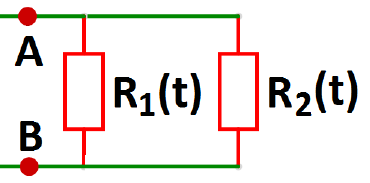
Figure 10. Two nonlinear loads R(t) operating simultaneously.